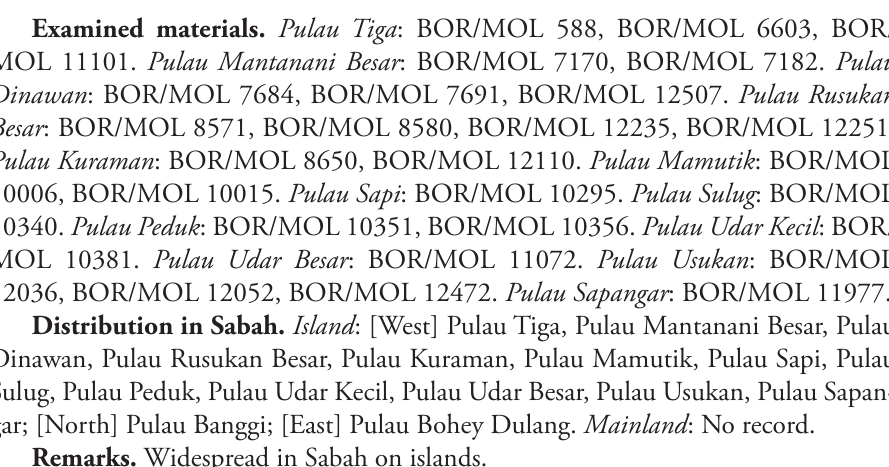
Type locality. “India: Uttar Pradesh–between Jounpur and Benares” (Benson